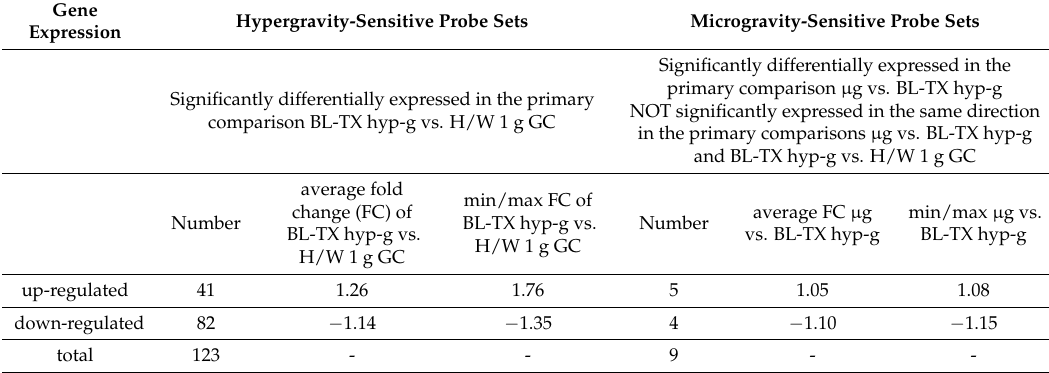
Table 5. Identification of hyper- and microgravity-sensitive probe sets representing genes involved in HIF-1 signaling pathway in response to altered gravity conditions during TEXUS-51 sounding rocket flight in Jurkat T cells.